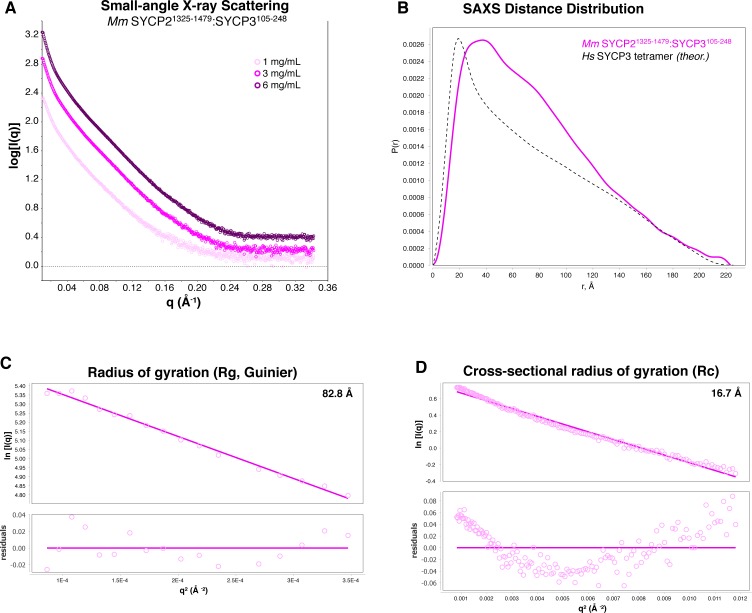
SAXS analysis of Mm SYCP2CC:SYCP3CC.(A) Small-angle x-ray scattering (SAXS) curves on the Mm SYCP2CC:SYCP3CC complex, at three different protein concentrations. The high slope in the low-scattering-angle region of the scattering curves indicates aggregation in the sample cell. (B) Intra-particle distance distribution of Mm SYCP2CC:SYCP3CC (magenta), compared to the calculated distance distribution of the Hs SYCP3CC homotretramer crystal structure (Syrjänen et al., 2014). (C) Guinier analysis of the low-scattering-angle region to determine radius of gyration (Rg) (Feigin and Svergun, 1987). (D) Cross-sectional radius of gyration (Rc) analysis (Glatter and Kratky, 1982). The non-linearity evident in residual values, and the larger values of both Rg and Rc in Mm SYCP2CC:SYCP3CC compared to the Hs SYCP3CC-SYCP2CC fusion, are attributable to aggregation.